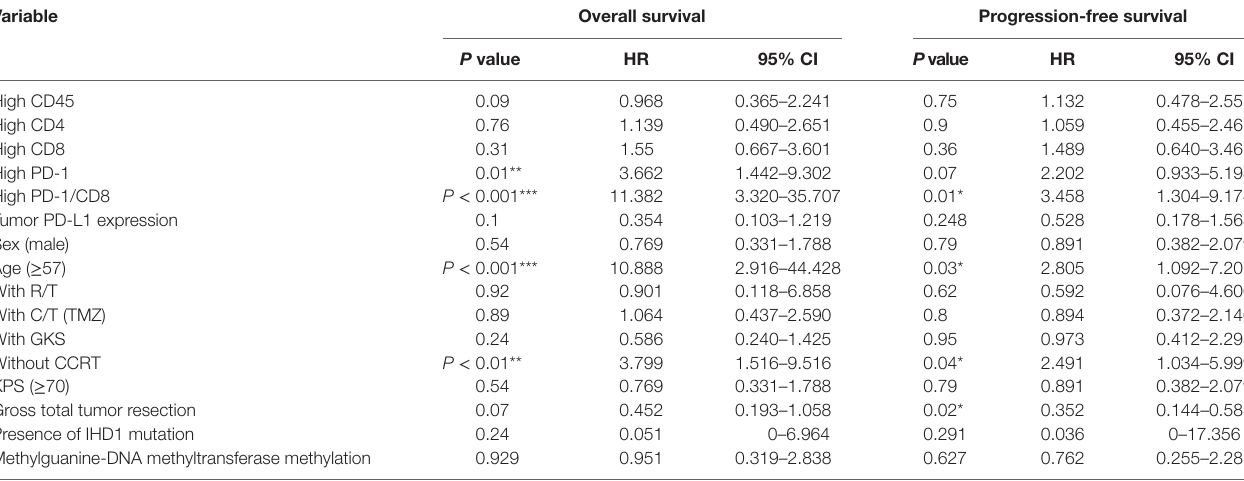
TaBle 5 | Multivariate analysis using a Cox proportional hazards model for overall survival and progression free survival in ADCTA group patients.